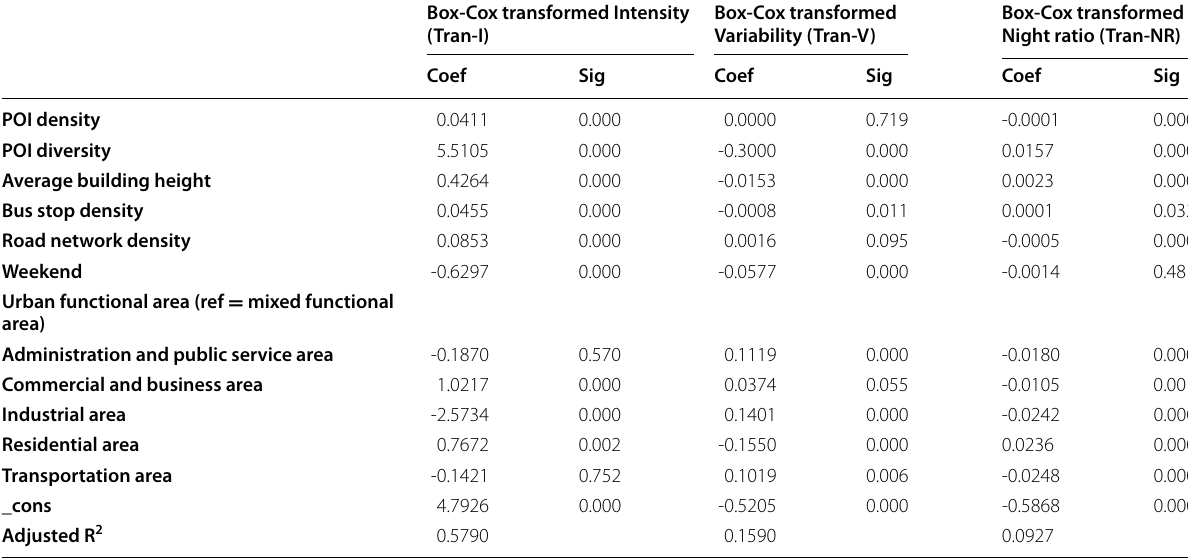
Dependent variables were box-cox transformed